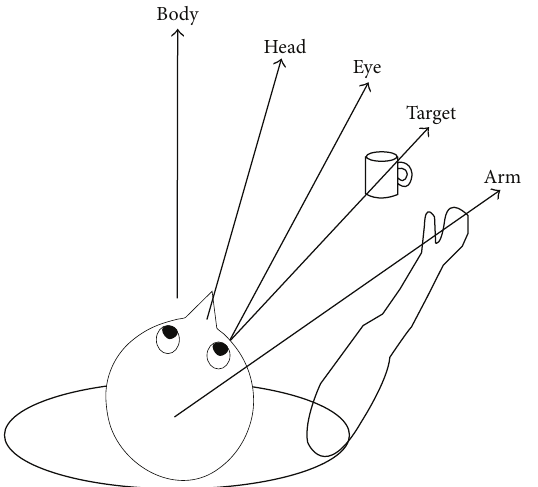
Figure 2: Frames of reference for visuomotor tasks. The required movement to grasp the mug is the angle from arm to target. This is the angle from body-to-arm minus the sum of the angles from target-to-fovea, eye-in-head, and head-on-body. In practice, eye, head, and body are often aligned before such a grasp movement, but such alignment is not essential (courtesy of Tatler and Land